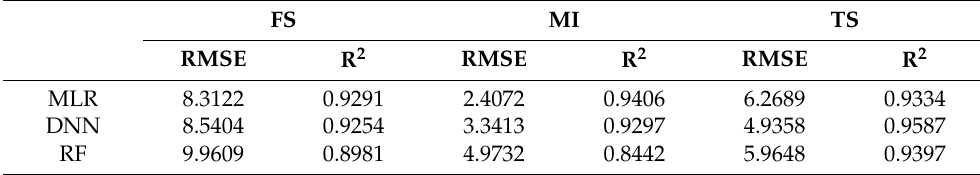
Table 7. RMSE and R 2 by prediction model for the three physical